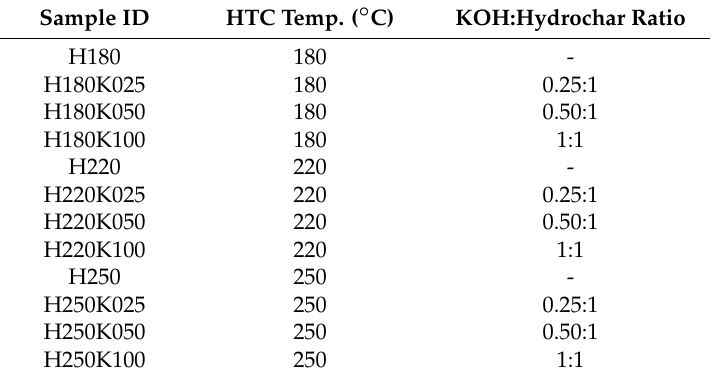
Table 1. Identification codes of hydrochars and activated carbon